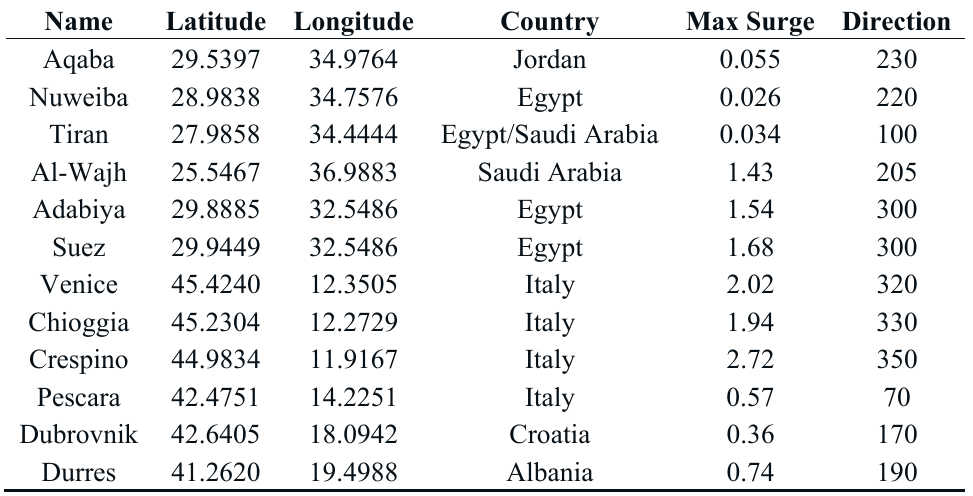
Figure 5. Red Sea surge height with wind blowing from southeast (300° Cartesian). Table 2. Site names and locations for the Red Sea and Adriatic Sea. Latitude and longitude are in decimal degrees north and east. The maximum simulated surge heights are in meters, and the wind directions are given in Cartesian